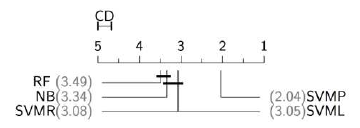
Figure 6: Comparison of classifiers over all MNIST experiments Classifier Selection: our experiments indicate that SVM